Question: From the figure, is the trend upward or downward?
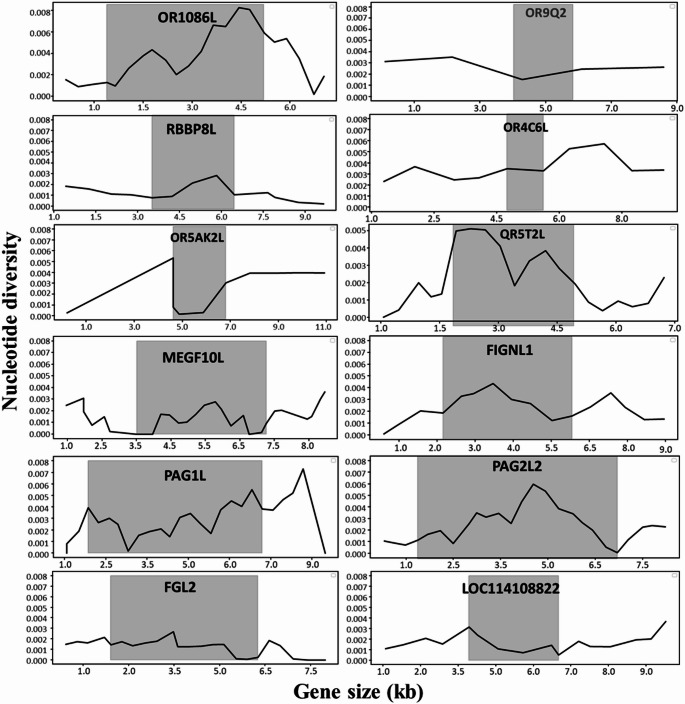
Answer: increasing